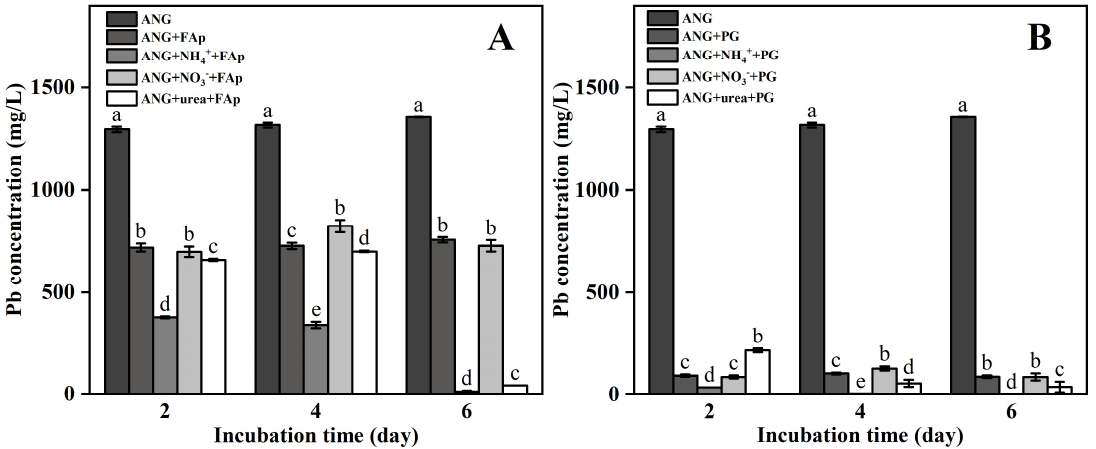
Figure 4. Concentrations of Pb between FAp ( A ) and PG ( B ) treatments during the incubation (2, 4, and 6 days). The error bars represent the standard deviations of three replicates. The different lower-case letters indicate a significant difference between the treatments ( p < 0.05). The significant differences among the treatments were identified by Tukey test ( p < 0.05) via one-way ANOVA. The concentrations of TCLP-Pb in ANG treatment were 3705, 3074, and 3145 mg/L on days two, four, and six, respectively (Figure 5). In ANG + FAp, ANG + NH 4+ + FAp, ANG + NO 3 − + FAp, and ANG + urea + FAp treatments, the concentrations of TCLP- Pb decreased to 294, 469, 297, and 284 mg/L after two days of incubation (Figure 5A).